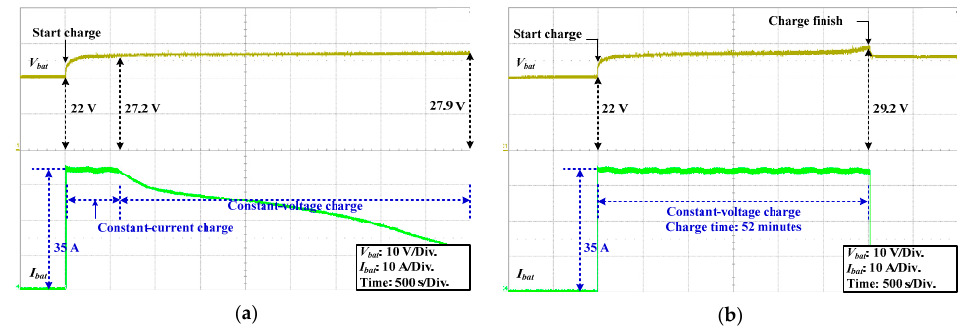
Figure 27. Charge profiles. ( a ) CC–CV charge strategy. ( b ) CC charge strategy.